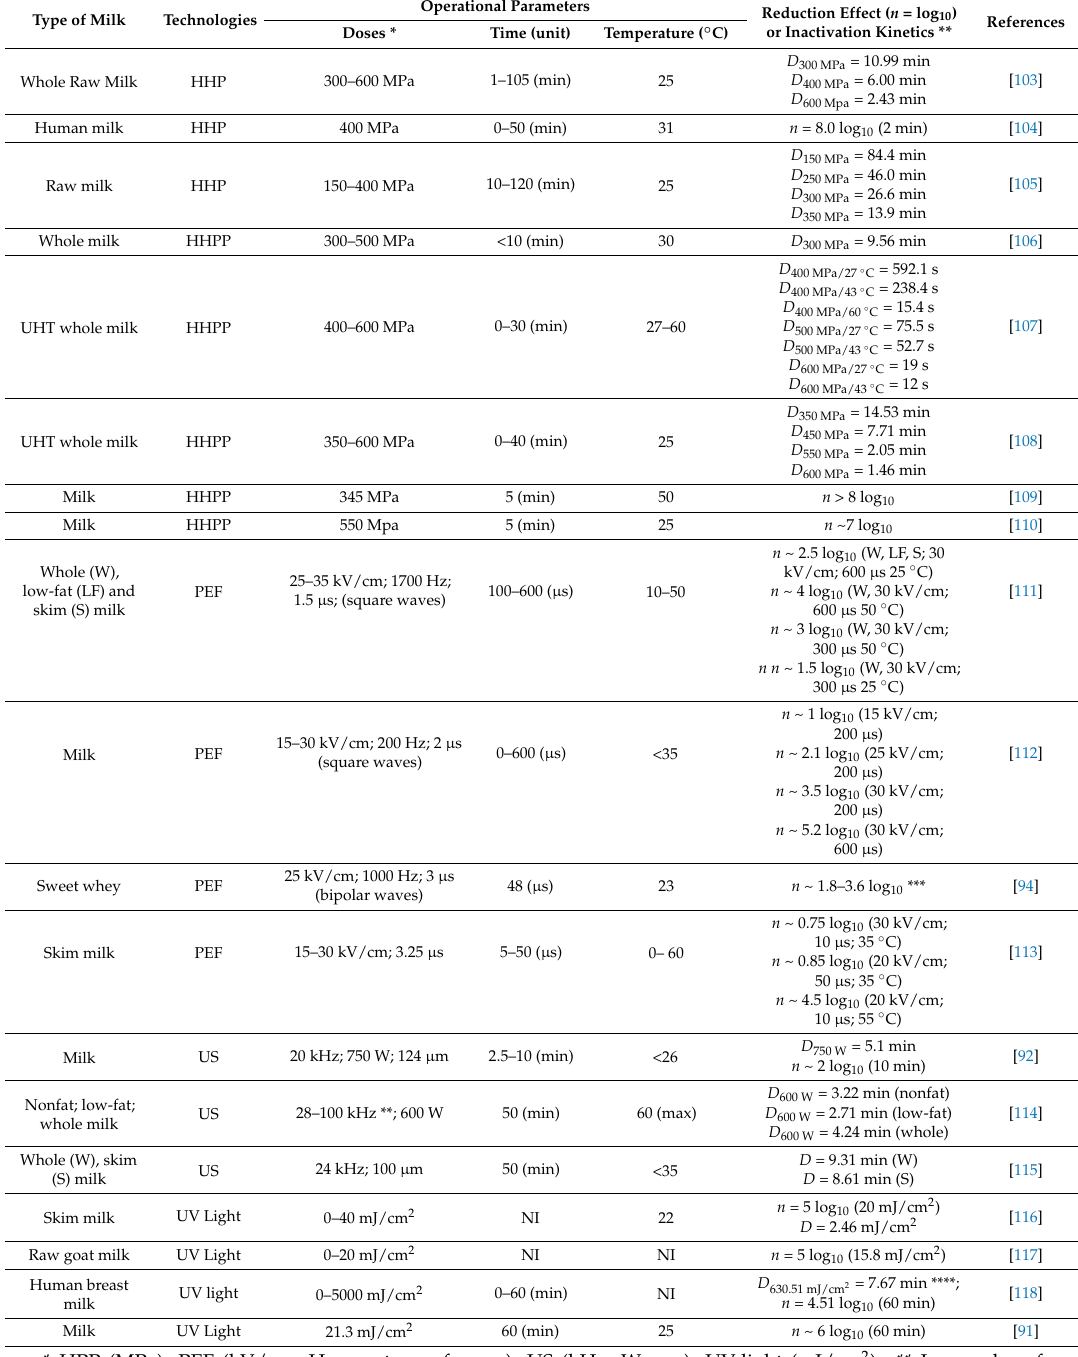
Table 3. Recent studies on nonthermal technologies for the inactivation of L. monocytogenes in milk. HHP: High hydrostatic